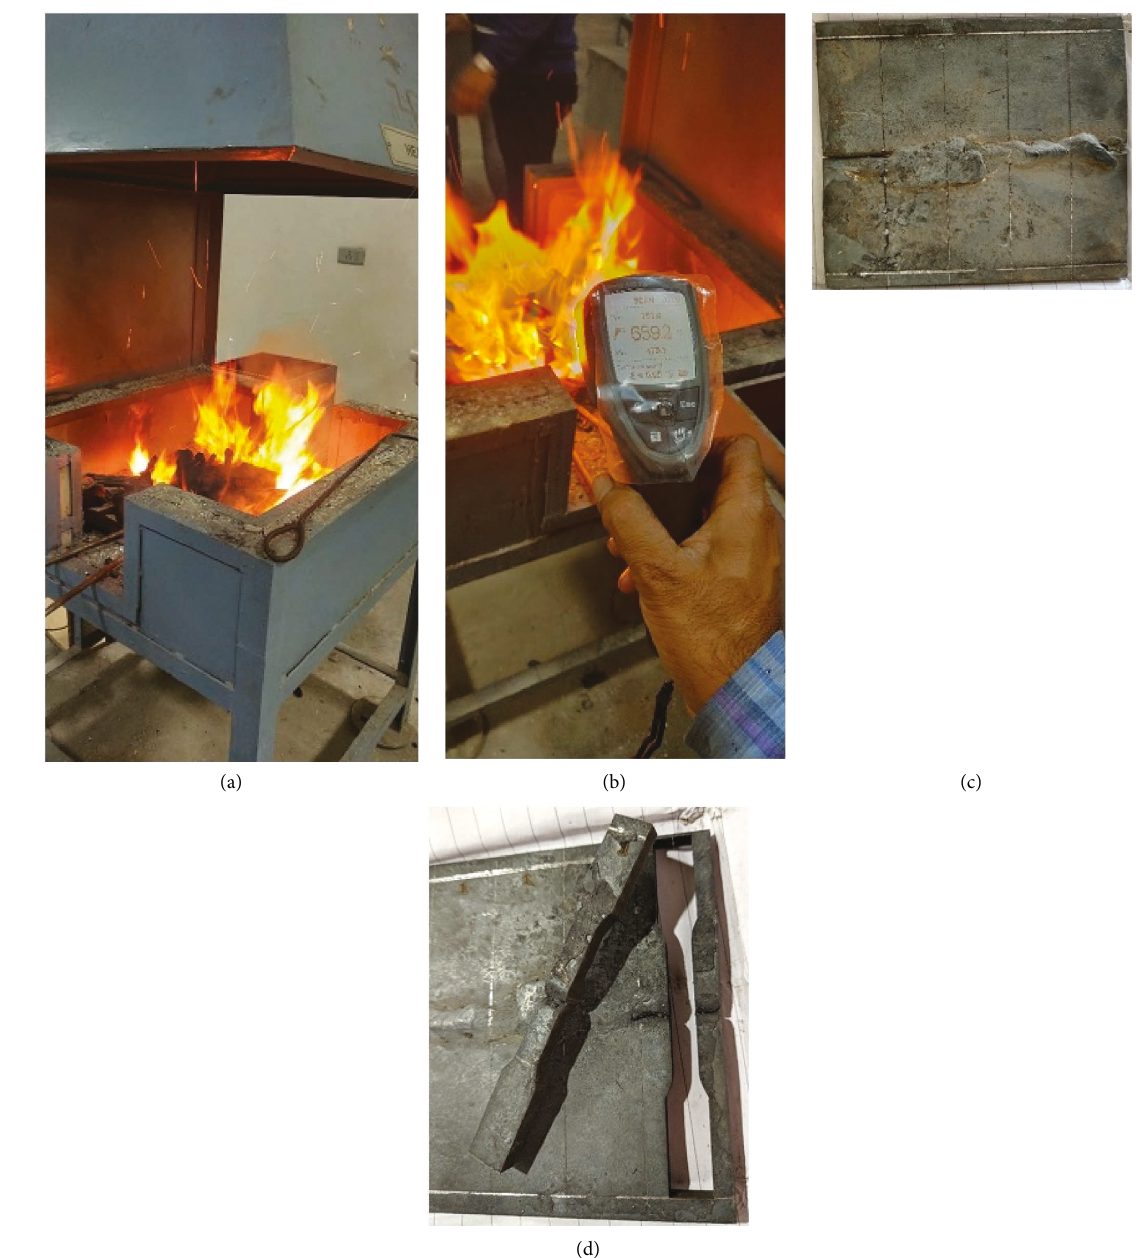
Figure 1: Experimental procedure. (a) Welded plates were heated in an open-hearth furnace; (b) temperature values were observed by using a pyrometer; (c) sample preparation for further analysis; (d) a tensile test specimen prepared by using